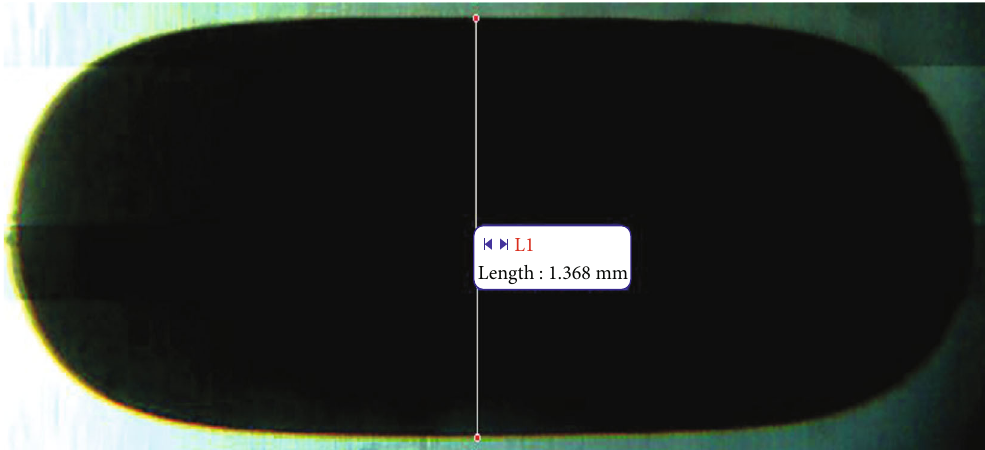
Figure 5: Crude oil drop deformation due to the decrease of interfacial tension between it and 5.000 ppm NaCl water phase using the COP 30 w/w% AA+LA – 5% AO at